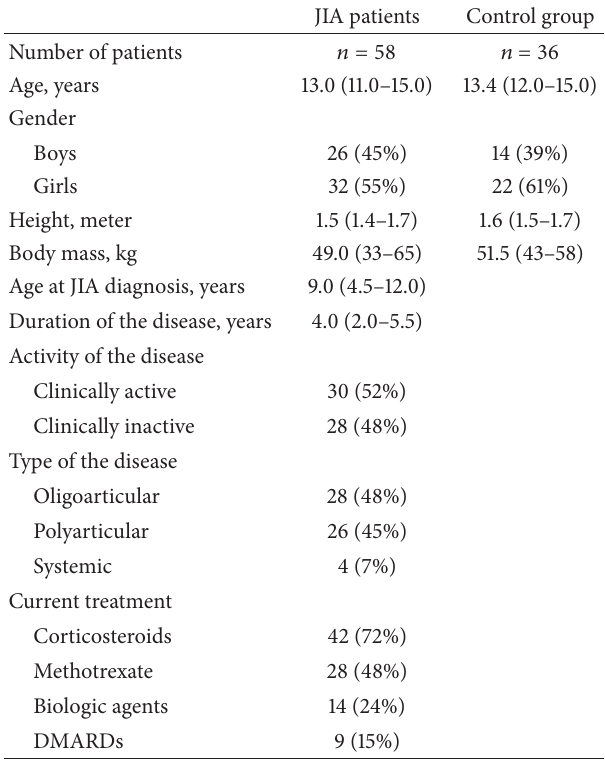
Table 1: Demographic and clinical characteristics of the juvenile idiopathic arthritis (JIA) patients and the control